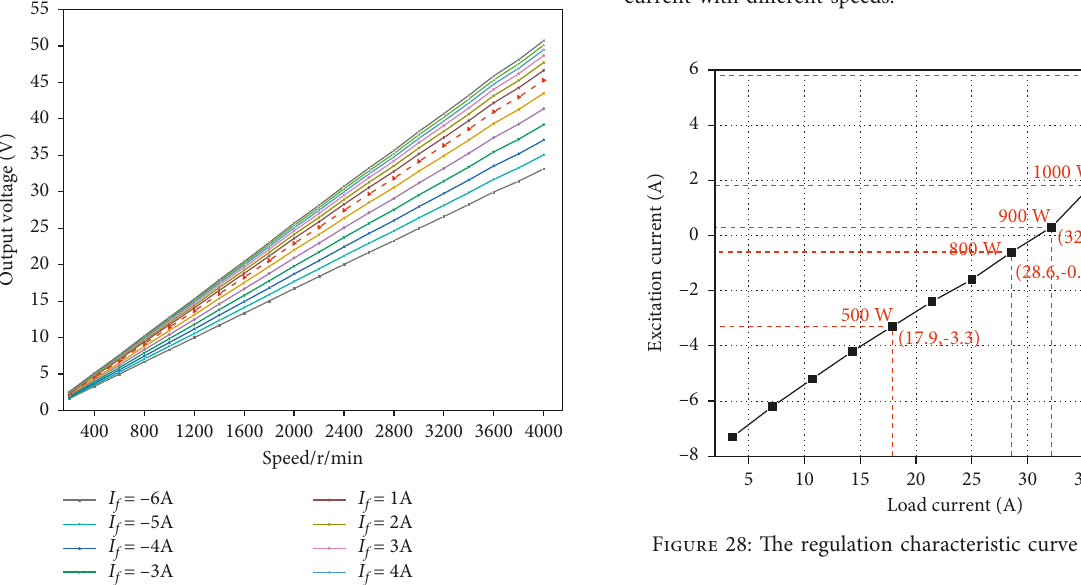
Figure 27: Variation curves of HEG output voltage and excitation current with different speeds.